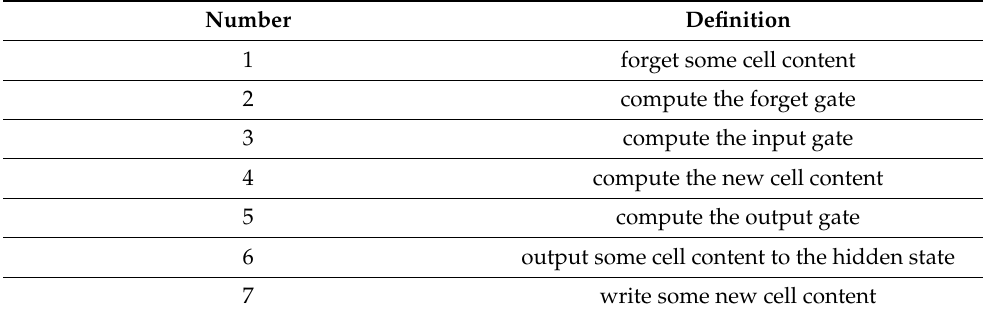
Figure 5. The long short-term memory diagram of a cell-state. In this figure, different operators are indicated as numbers 1–7. Each number demon ‐ strates the different state of data, which is shown in Table 2. Table 2. The definition of different signs of the long short-term memory diagram of a